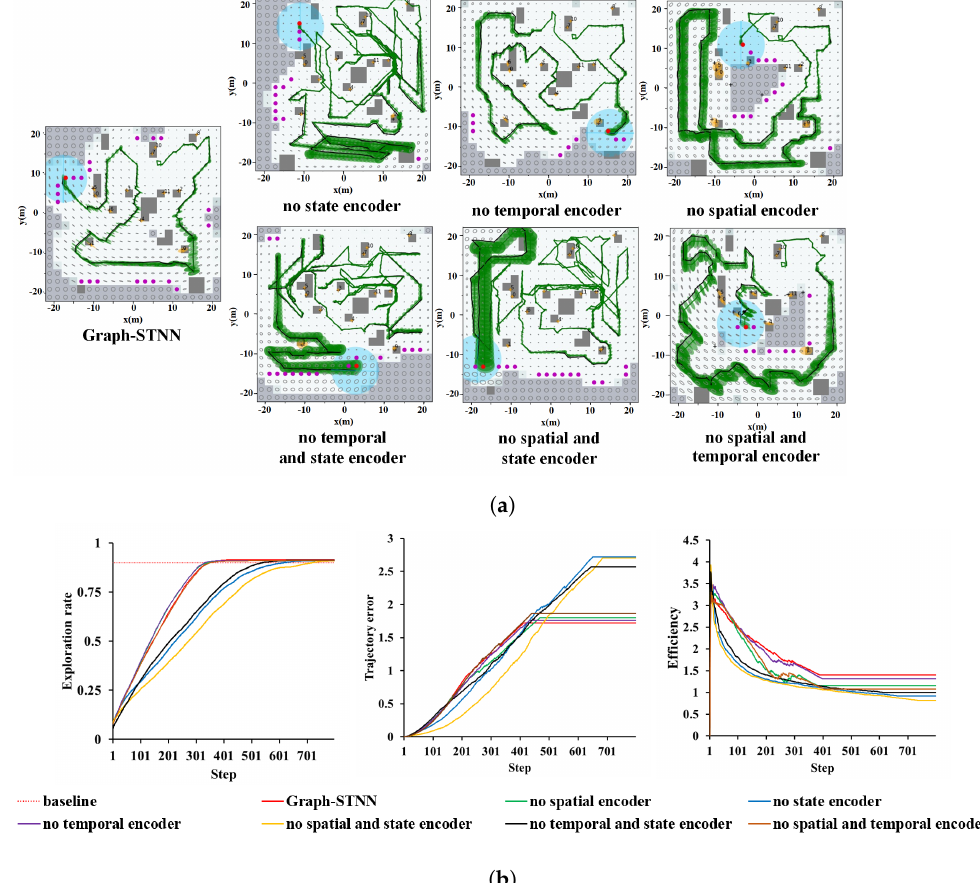
Figure 15. The result of 50 exploration trials of Graph-STNN and the removal of its components, with the model trained in 20 m × 20 m maps and the same initialized landmarks and robot’s start locations, on 40 m × 40 m maps. ( a ) One of the test result of 50 exploration trials. ( b ) Average exploration rate (left), trajectory error (middle), and exploration efficiency